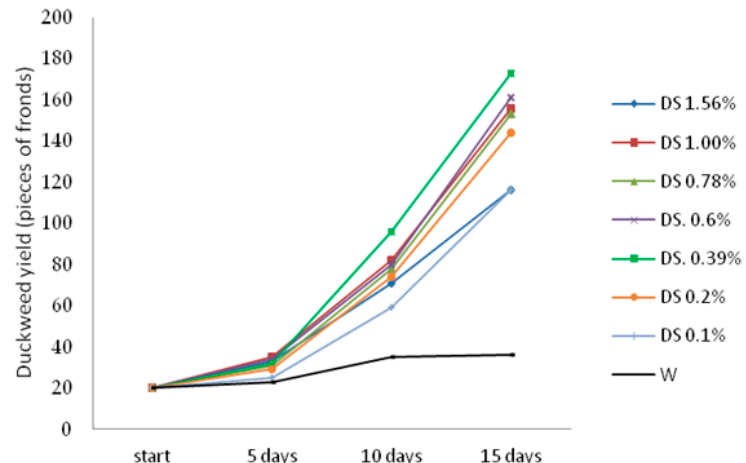
Figure 1. Yield of duckweed cultured on growth medium with different concentrations of the digestated from the biogas plant (DS).